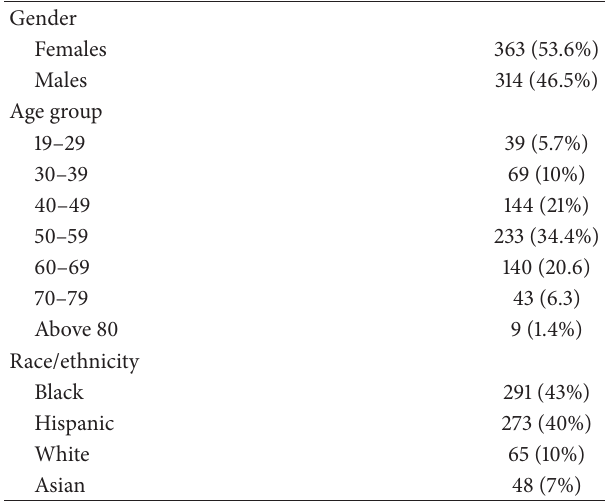
Table 1: Demographic characteristics of the study population (total number 677).